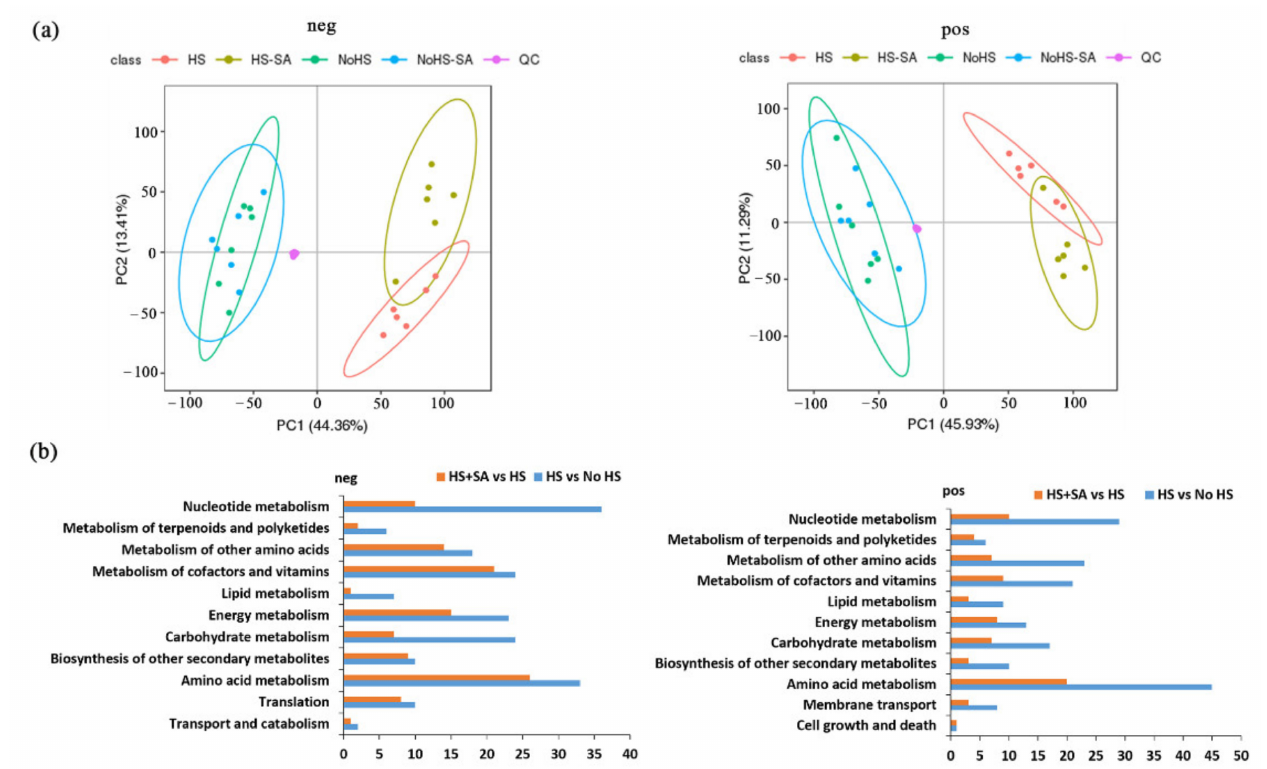
Figure 2. Metabolome and KEGG cluster analyses. ( a ) Principal component analysis (PCA) was used to separate metabolites between experimental groups. HS: heat stress; HS + SA: heat stress + salicylic acid; No HS: No heat stress; No HS + SA: No heat stress + salicylic acid; neg: the negative mode; pos: the positive mode; ( b ) KEGG cluster analysis of metabolites with significant